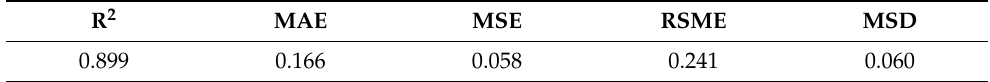
Table 1. Performance metrics of the moisture forecasting model. R 2 MAE